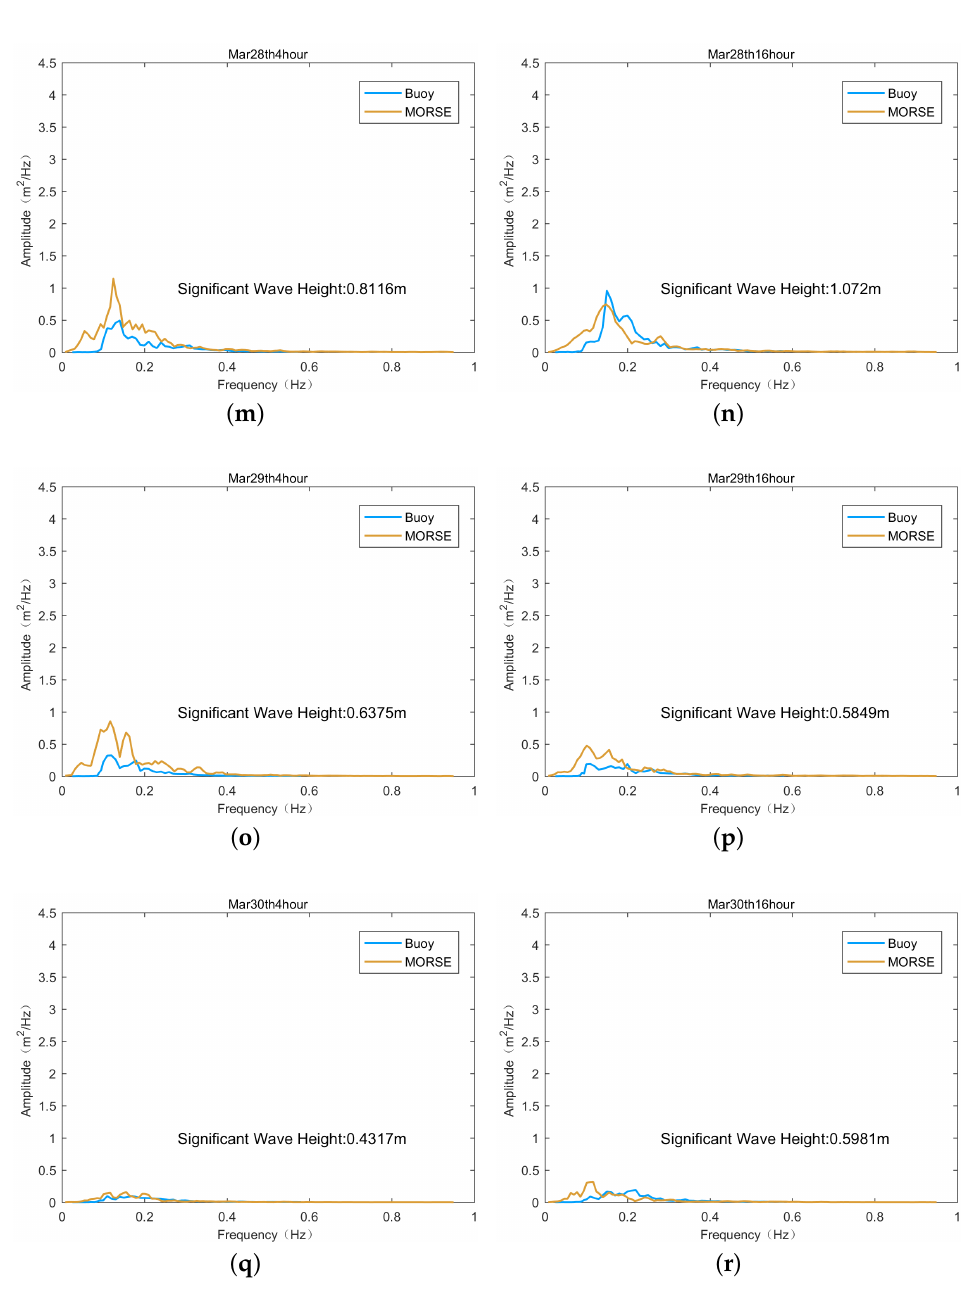
Figure 10. Non-directional wave height spectra